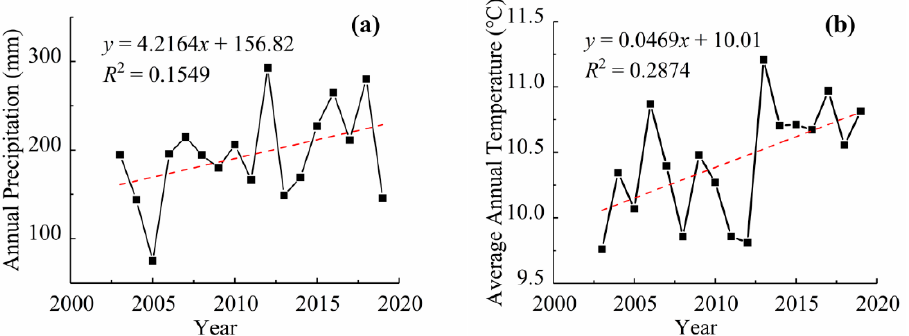
Figure 5. Annual precipitation ( a ) and average annual temperature ( b ) in Lingwu County from 2003 to 2019. to